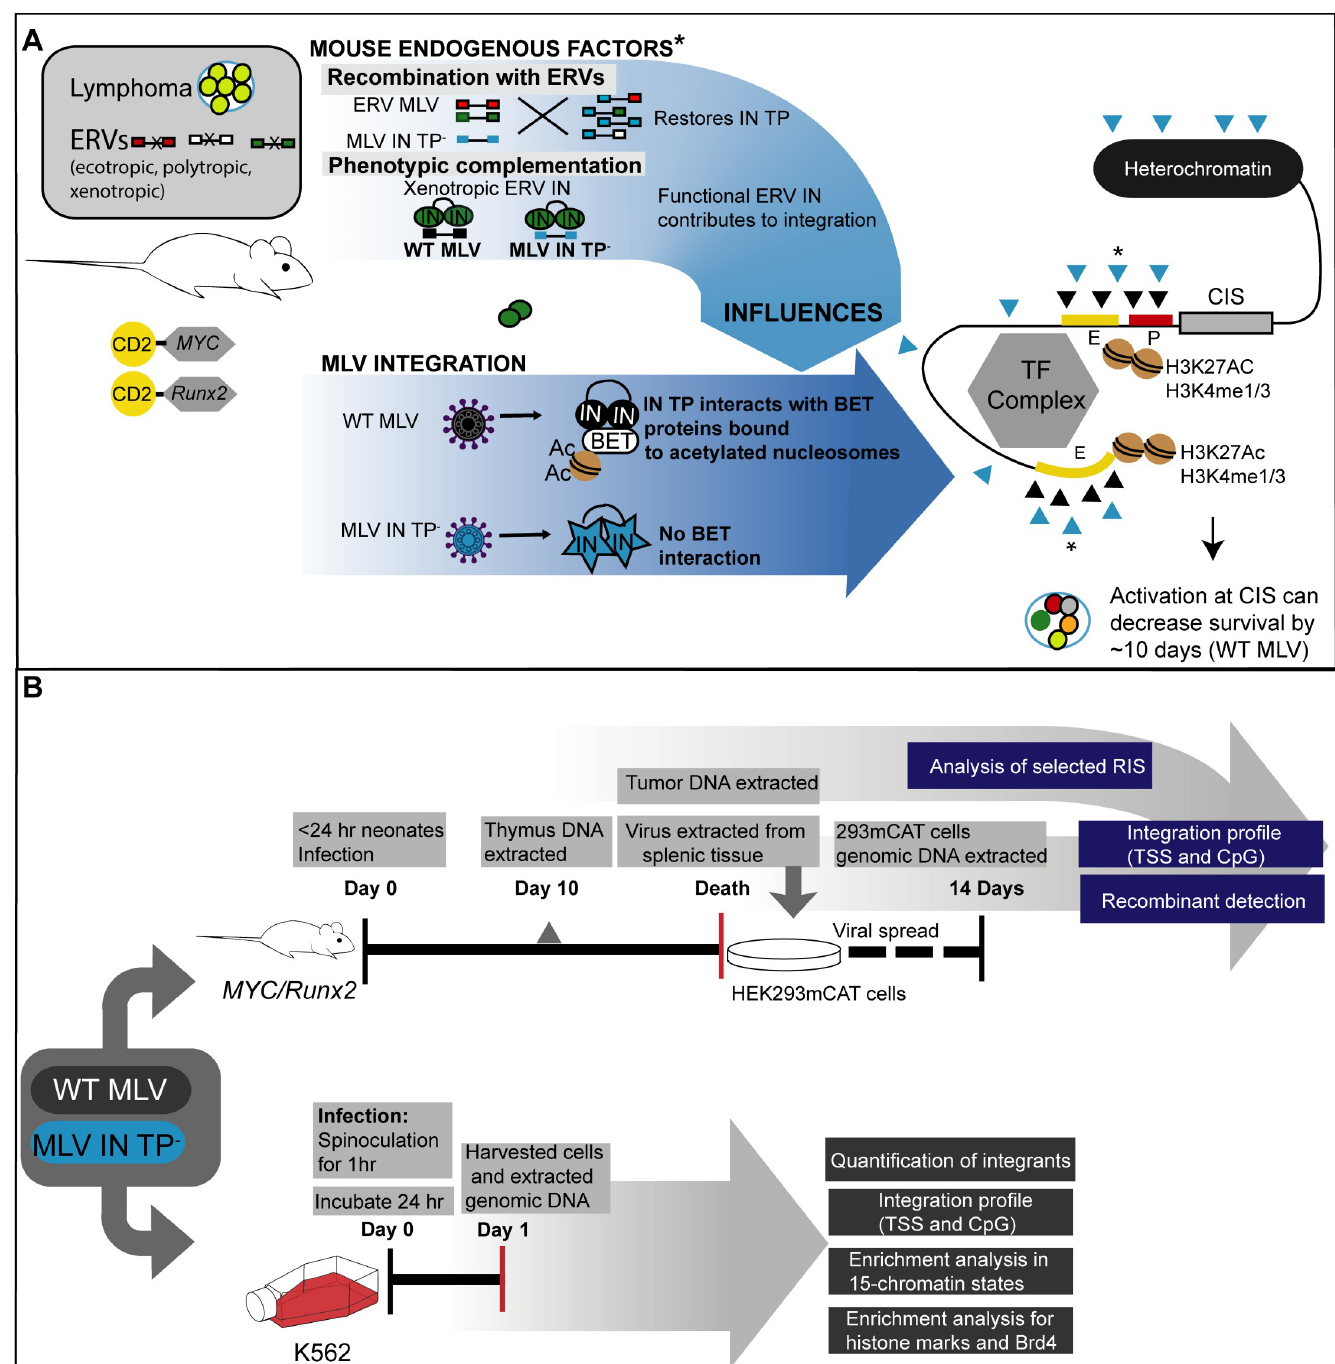
Fig 2. MYC/Runx2 mouse model and K562 cell study workflows. (A) Overall outline of the MYC /Runx2 mouse and MLV infection. Transgenic expression of the MYC and Runx2 genes from the CD2 promoter in the C57BL6 x CBA/Ca mice results in the production of lymphomas. The mice encode endogenous retroviruses (ecotropic, polytropic and xenotropic MLVs) that can influence exogenous infecting viruses through either recombination or protein complementation if functional GagPol proteins are expressed (marked by asterisk). Infection with WT MLV (black circles) results in the IN protein interacting with host BET proteins (white oval) that bind acetylated histone marks. WT IN:BET protein interactions bias integration events (black triangles) towards promoters (P, red rectangle) and enhancers (E, yellow rectangles) through the BET nucleosome mark recognition. Integration events at known common insertions sites (CISs) result in early onset lymphomagenesis. Experiments in this manuscript examine the effects of infection of MLV IN TP - virus that has lost the interaction with the BET proteins (blue stars). Experiments map the positions of IN TP - integrations (blue triangles) with respect to promoters, enhancers, chromatin marks and known CISs in relation to the time of tumor